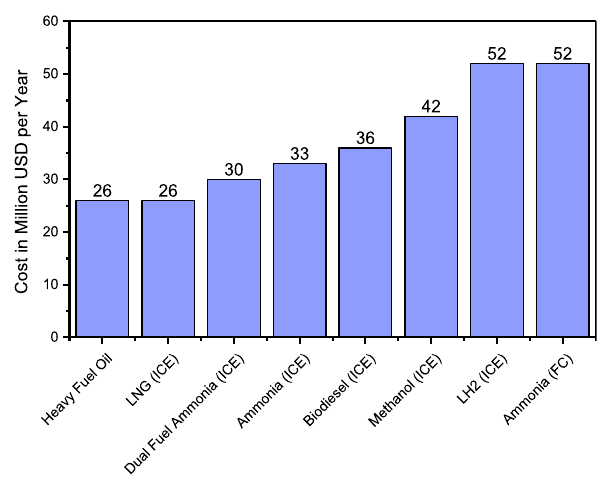
Fig. 19 Annual price for operating a container ship and a bunkering location in the Middle East in 2030, data obtained from Statista